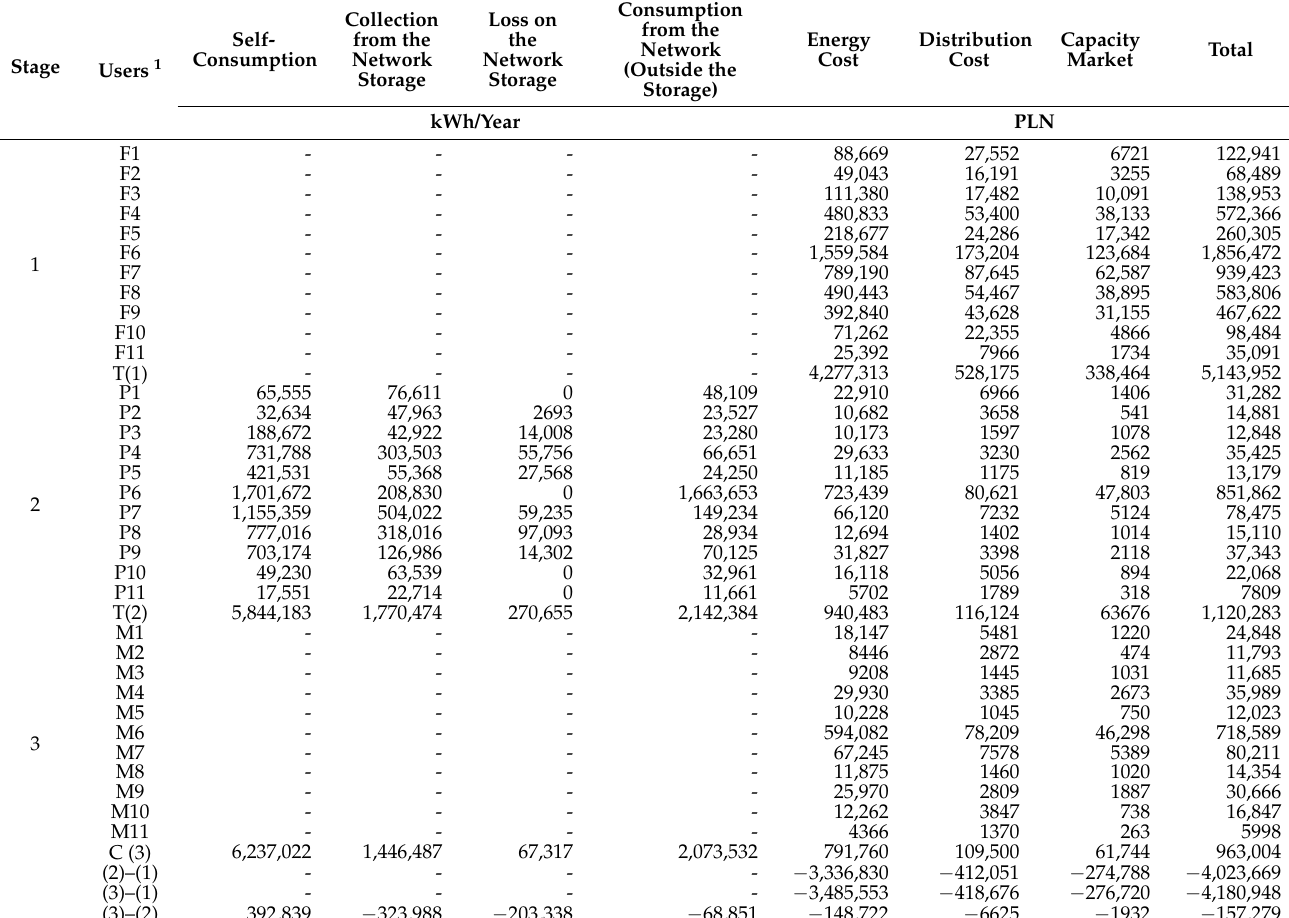
Table 5. Economic calculations